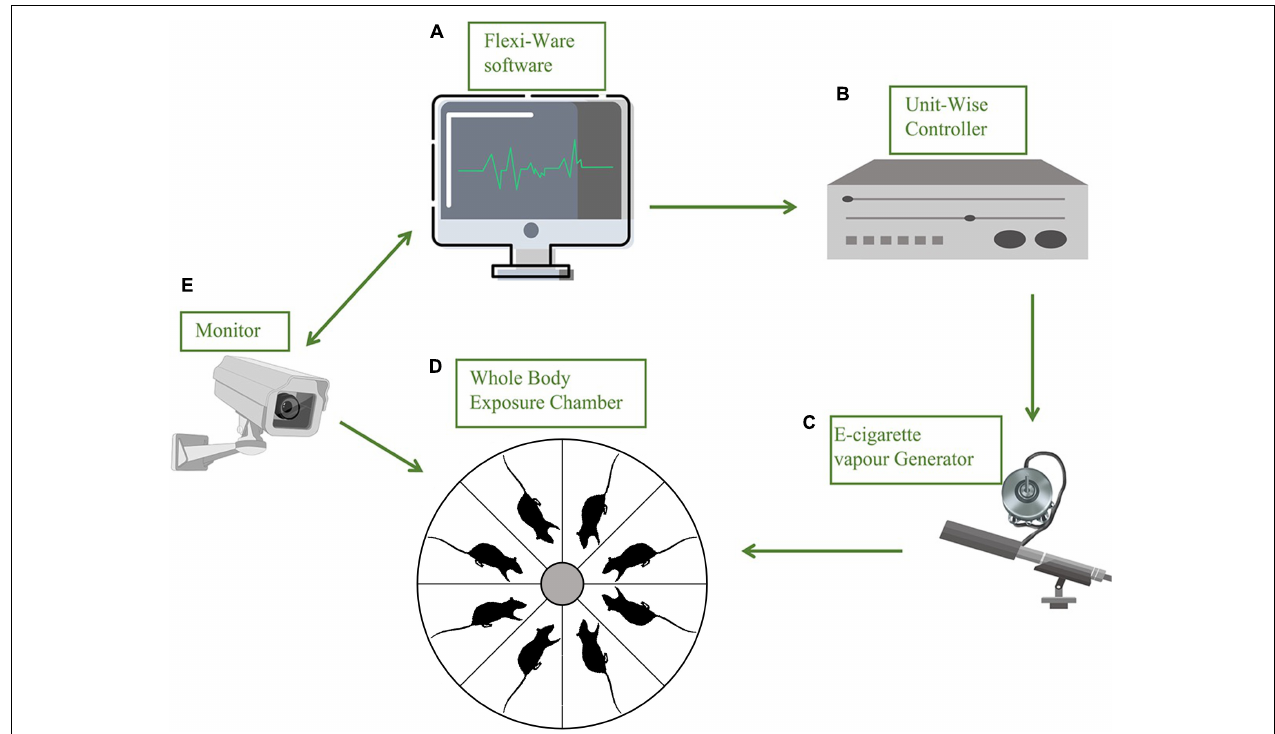
FIGURE 1 | Schematic diagram of a precise substance vapor device. Each part of the device is represented by a stick figure. (A) Flexiware software: the exposure temperature, patterns of smoking and humidity, and the exposure time and duration can be modified practically by the computerized exposure system; (B)